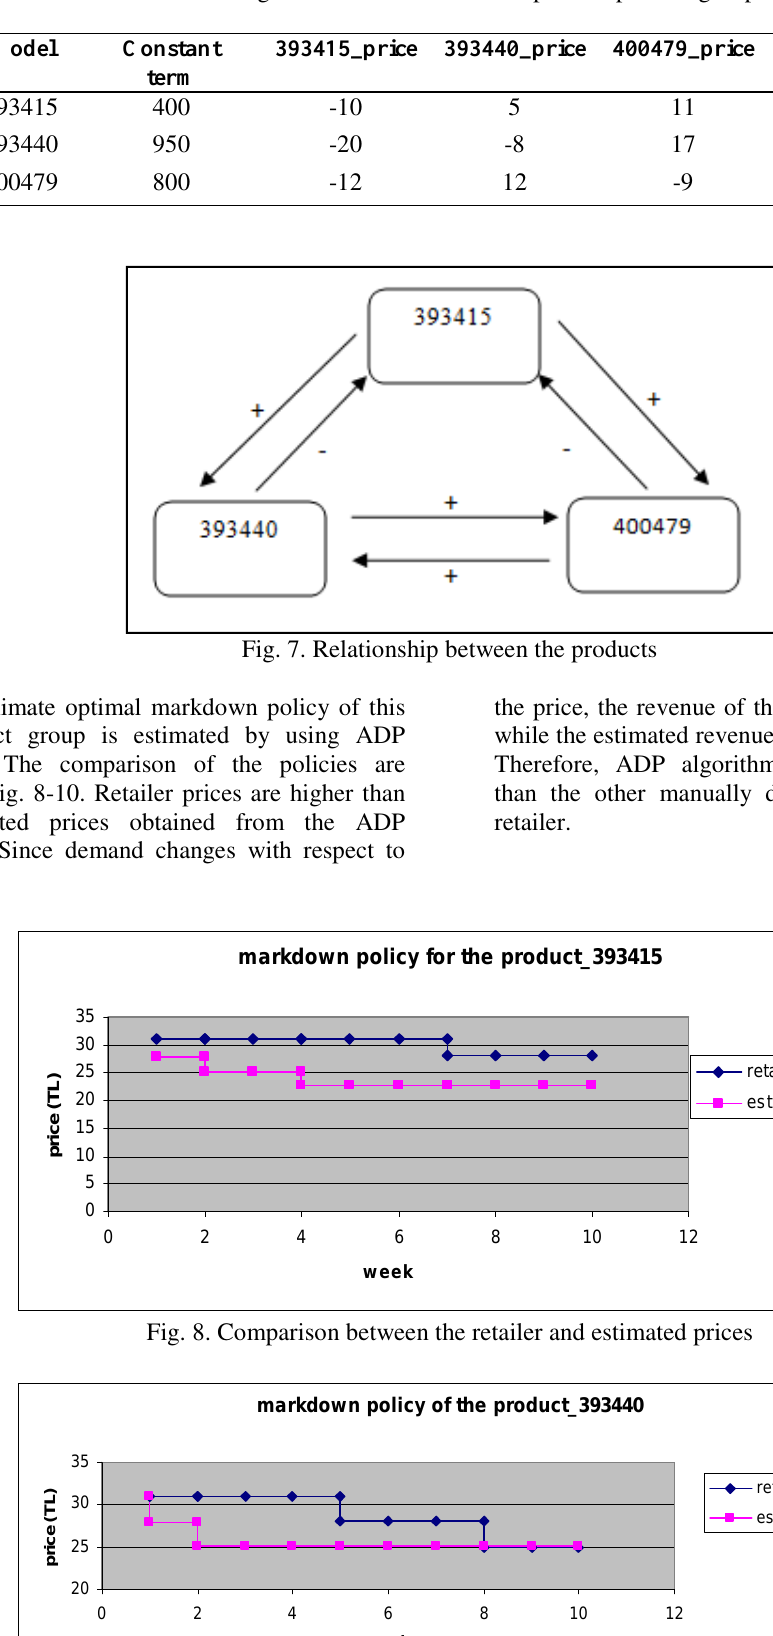
Table 8. Regression model of the example mutiproduct group